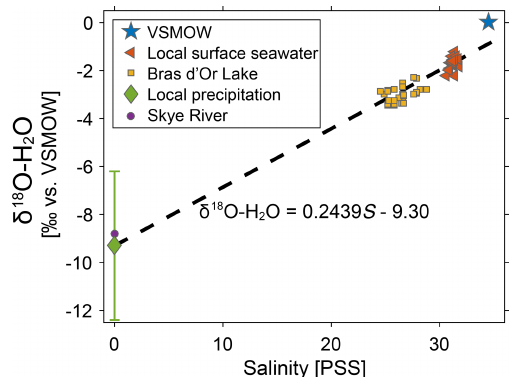
Figure 5. δ 18 O-H 2 O regression versus salinity. Measurements of δ 18 O-H 2 O in local surface seawater, the Bras d’Or Lake, local precipitation, and the Skye River (within the Whycocomagh Bay watershed). The regression is calculated using the local precipita- tion and seawater values. The local precipitation value is plotted as 9.3(3.1)‰, with the error bar the standard deviation of the amount- weighted annual